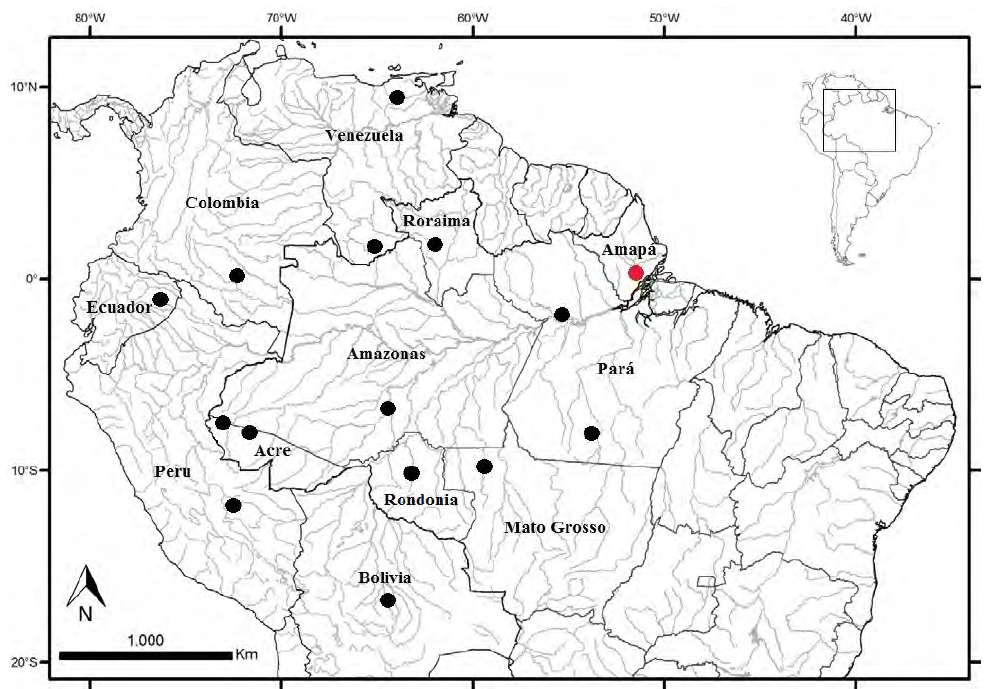
Hypsiboas lanciformis in Brazil. Black circles represent the historical distribution (Azevedo- in the state of